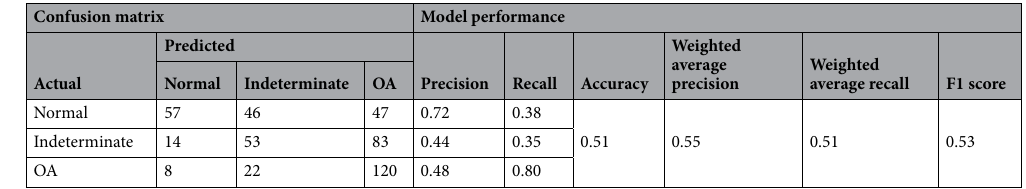
Table 2. Confusion matrix and model performance for the initial AI. Indeterminate, indeterminate temporomandibular joint osteoarthritis; OA, temporomandibular joint osteoarthritis.